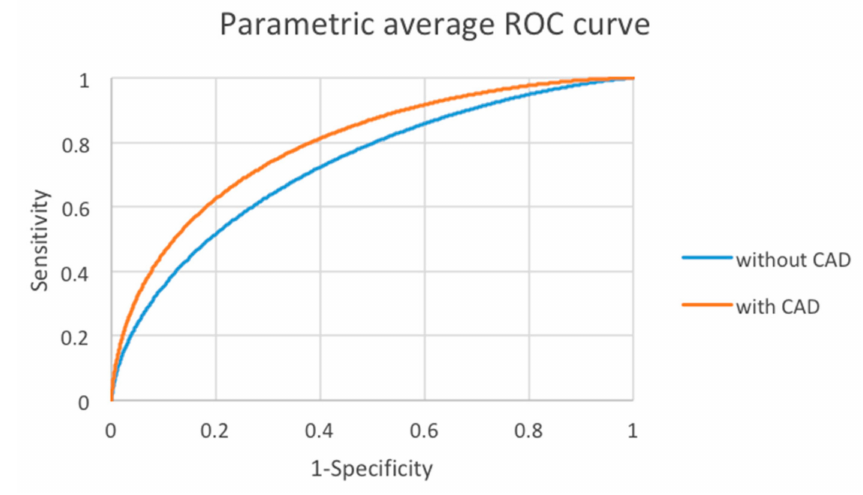
Figure 2. Average area under the curve (AUC) without and with CAD of all readers. Red = with CAD; Blue = without CAD.